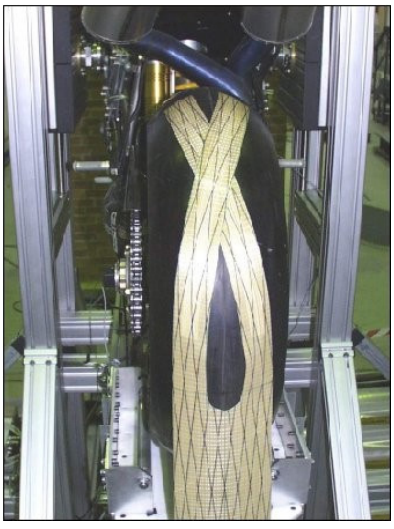
Figure 8. Two separate Mylar belts are used to apply tractive and braking forces.